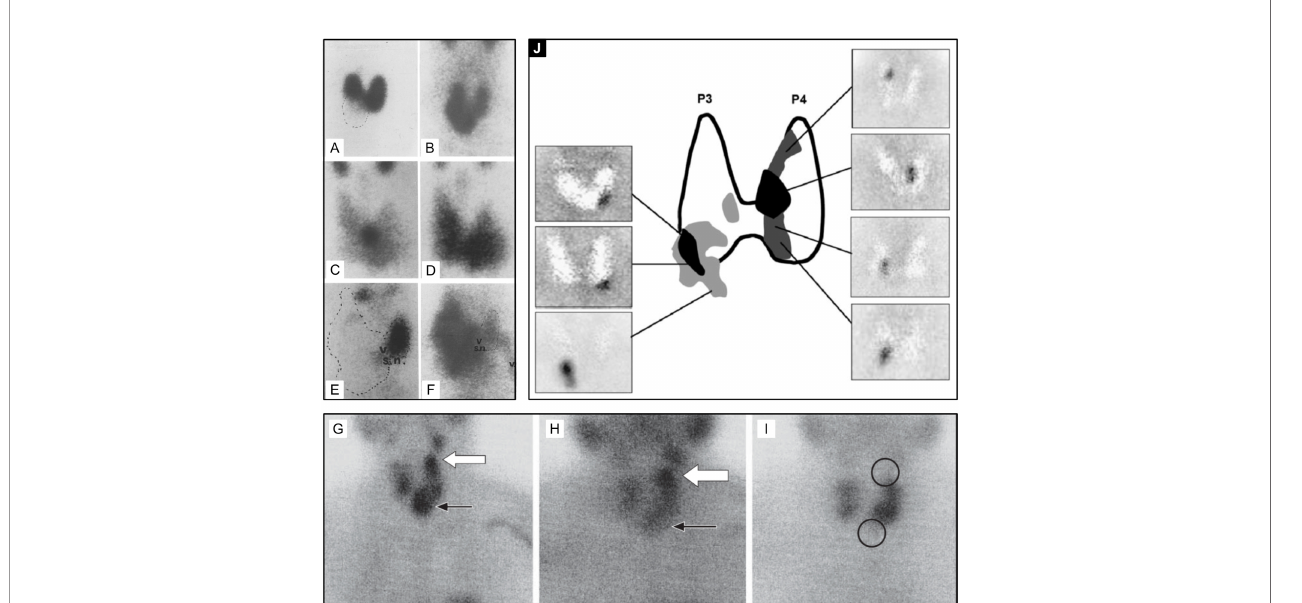
FIGURE 5 | 99mTc-sestamibi with or without 99mTc-pertechnetate imaging is the current standard of care for PA detection at most institutions at the time of writing of this article. Thyroid nodules may confound parathyroid imaging using this method as they have variable uptake relative to the thyroid gland with 99mTc- pertechnetate (A, C, E, I) and with 99mTc-sestamibi (B, D, F, G, H) . Although benign thyroid nodules typically washout on delayed 99mTc-sestamibi imaging (H) , thyroid carcinoma [ (G, H) , white arrow] can have retained uptake similar to parathyroid adenoma [ (G, H) , black arrow]. Panel (J) provides an atlas of PA appearances on dual tracer 99mTc-sestamibi minus 99mTc-pertechnetate subtraction and the frequency of PA locations relative to the thyroid gland (highest frequency-black, lower frequency-grey). Superior PA are derived from the fourth pharyngeal pouch (P4) and therefore more posterior. Inferior PA are derived from the third pharyngeal pouch and therefore more anterior (P3). SPECT imaging can aid in distinguishing the anterior versus posterior location. Reproduced with permission from: (A – F) Földes I, Le ́ vay A, Stotz G. Comparative scanning of thyroid nodules with technetium-99m pertechnetate and technetium-99m